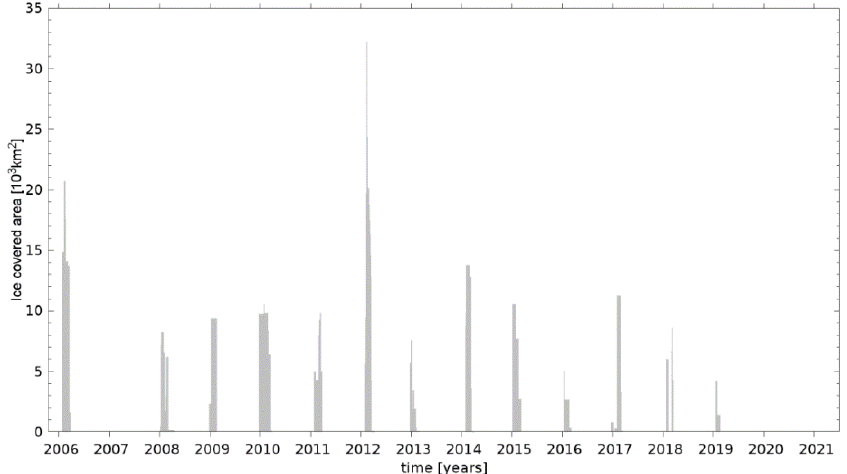
Figure 4. Daily sea-ice extent in the period 2006–2021 from MASIE-NH.